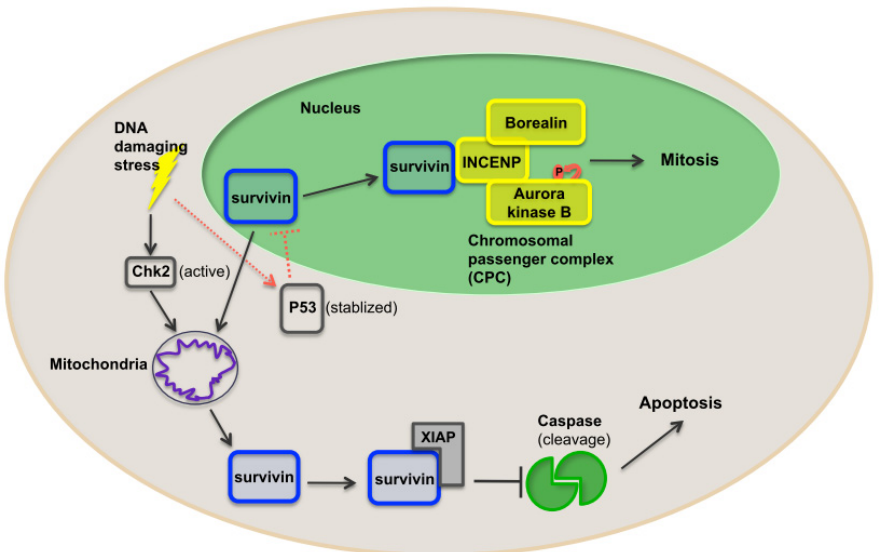
Figure 2. Pathways through which survivin can favor tumor cell development. Survivin is a component of the chromosome passenger complex (CPC) and a key regulator of chromosome segregation and cytokinesis. The association of survivin with two other components of the CPC complex, INCENP (inner centromere protein antigen) and borealin, regulate the localization of the aurora kinase B enzymatic component, to kinetochores. Aurora kinase B undergoes auto-phosphorylation upon recruitment to the CPC complex, promoting correct chromosome alignment, segregation and cytokinesis during